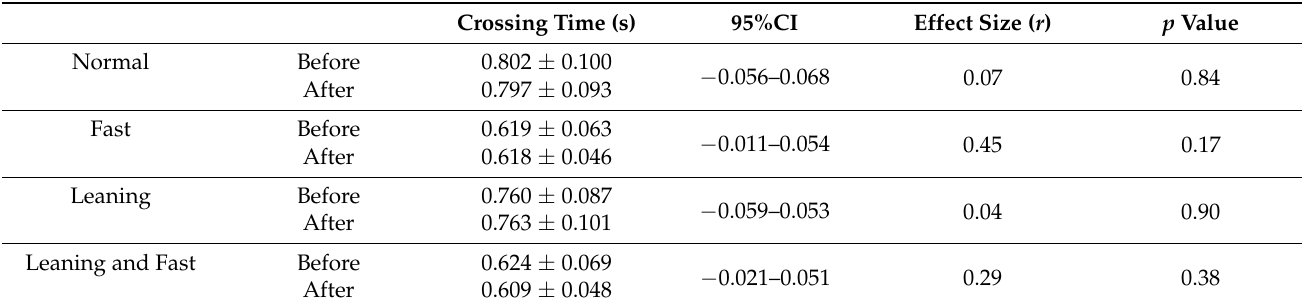
Table 9. Crossing time in the ATG for heel in lateral obstacle crossing.